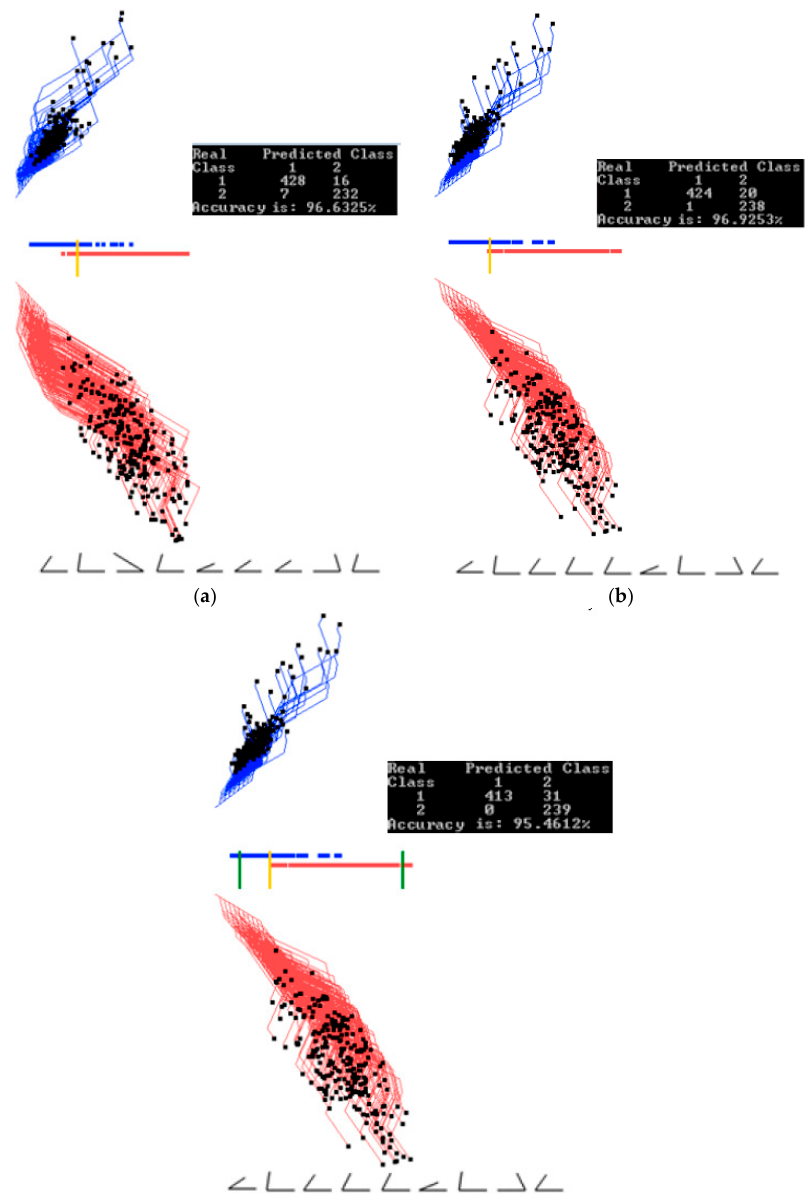
Figure 8. Wisconsin breast cancer data interactively visualized and classified in GLC-L for different linear discrimination functions. ( a ) Data visualized and classified using the best function of the first 20 runs of the random search with a threshold found automatically shown as a yellow bar; ( b ) Data visualized and classified using an alternative function from the first 20 runs with the threshold (yellow bar) at the positions having only one malignant (red case) on the wrong side and higher overall accuracy than in (a). ( c ) Visualization (b) where the separation threshold is moved to have all malignant (red cases) on the correct side with the tradeoff in the accuracy.